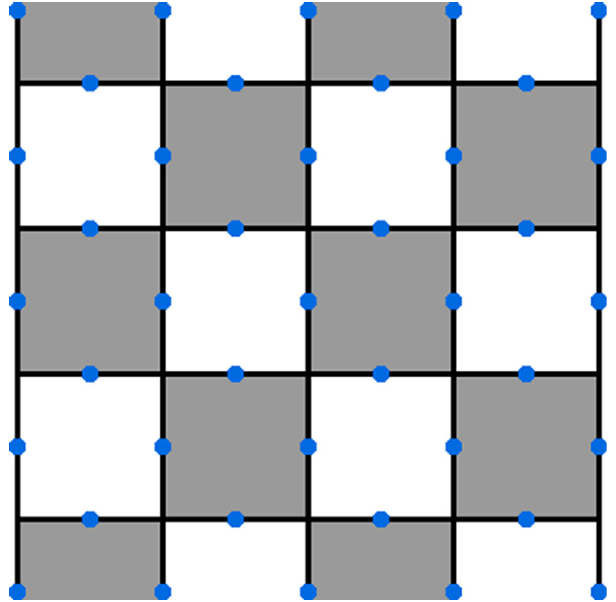
FIG. 2. Lattice used to simulate the Φ − Λ model. Six-level spins, shown by blue dots, are placed on each edge. Plaquettes are bicolored white and grey in chessboard fashion. The size of the lattice is measured by L , the number of spins along each edge. L ¼ 5 in the lattice